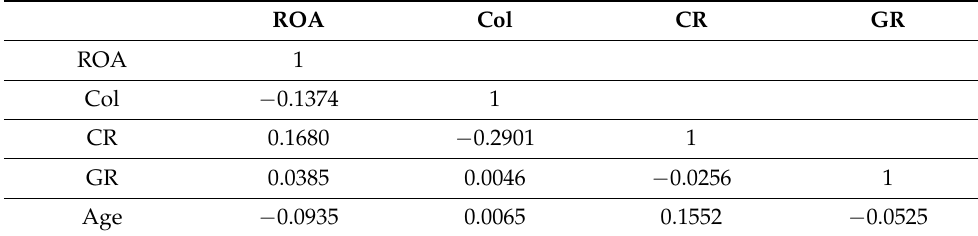
Table 2. Correlation between quantitative independent variables.